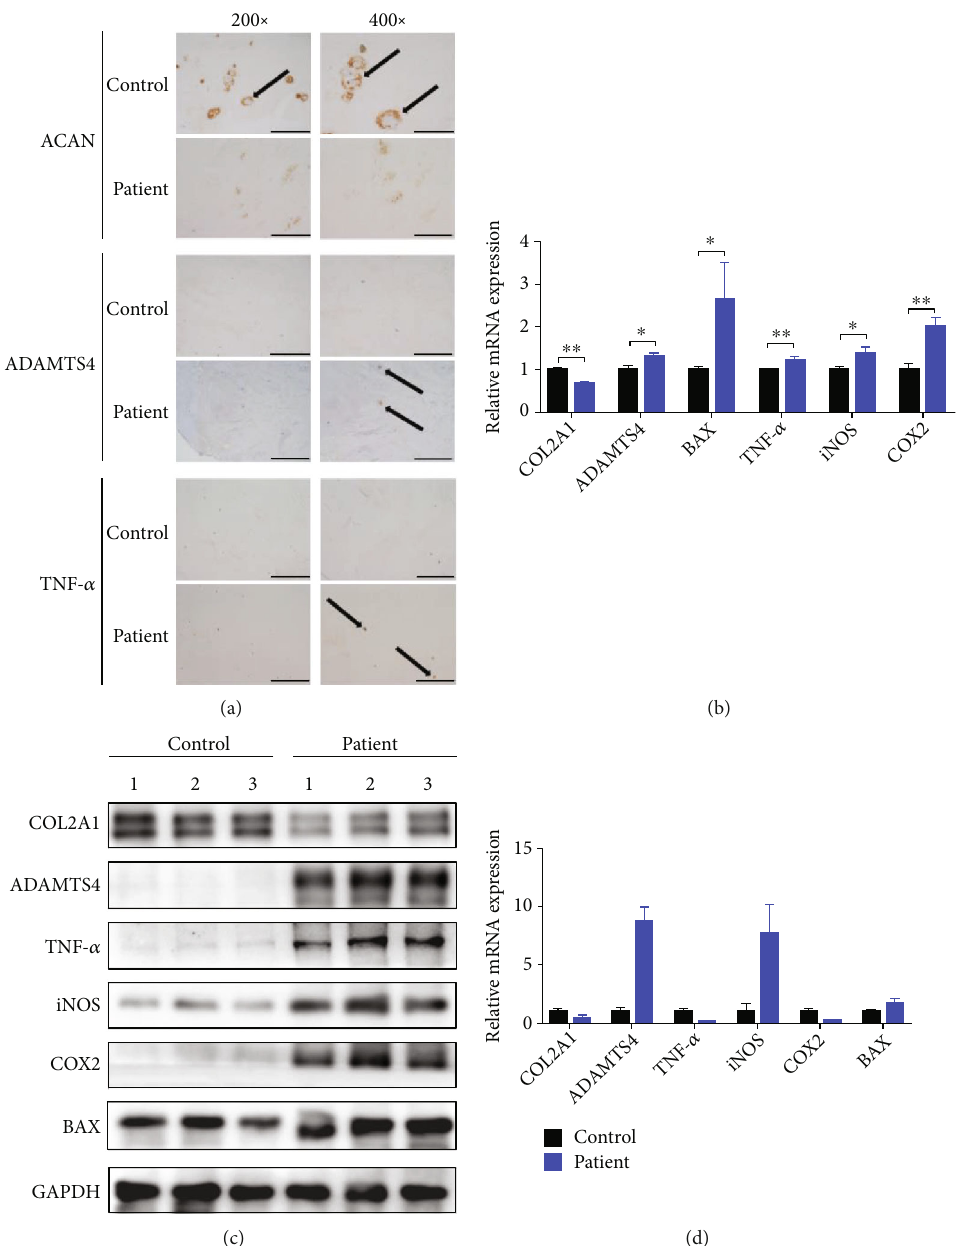
Figure 1: Dysregulated ECM metabolism, increased apoptosis, and in fl ammatory in fi ltration in degenerated NP tissue. (a) Immunohistochemical staining assay of ACAN, ADAMTS4, and TNF- α in normal and degenerated human NP tissues. (b) The mRNA expression levels of COL2A1 , ADAMTS4 , BAX , TNF- α , iNOS , and COX2 were detected by qPCR in normal and degenerated human NP tissues. (c, d) Protein expression levels of COL2A1, ADAMTS4, BAX, TNF- α , iNOS, and COX2 were detected by western blotting in normal and degenerated human NP tissues. The densities of the protein bands were assessed and quanti fi ed using the ImageJ software. The left images (magni fi cation: × 200, scale bar: 100 μ m) and the right images (magni fi cation: × 400, scale bar: 50 μ m) are shown. ∗ P < 0 : 05 , ∗∗ P < 0 : 01